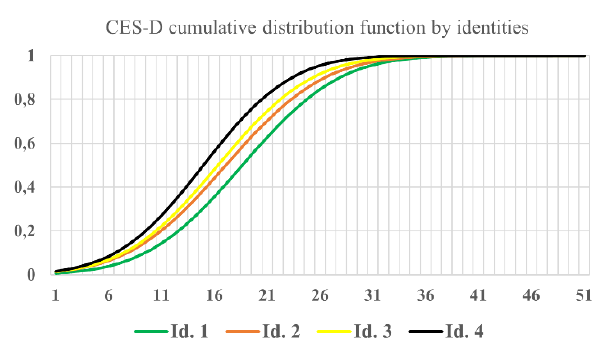
Figure 7 : Distribution function by